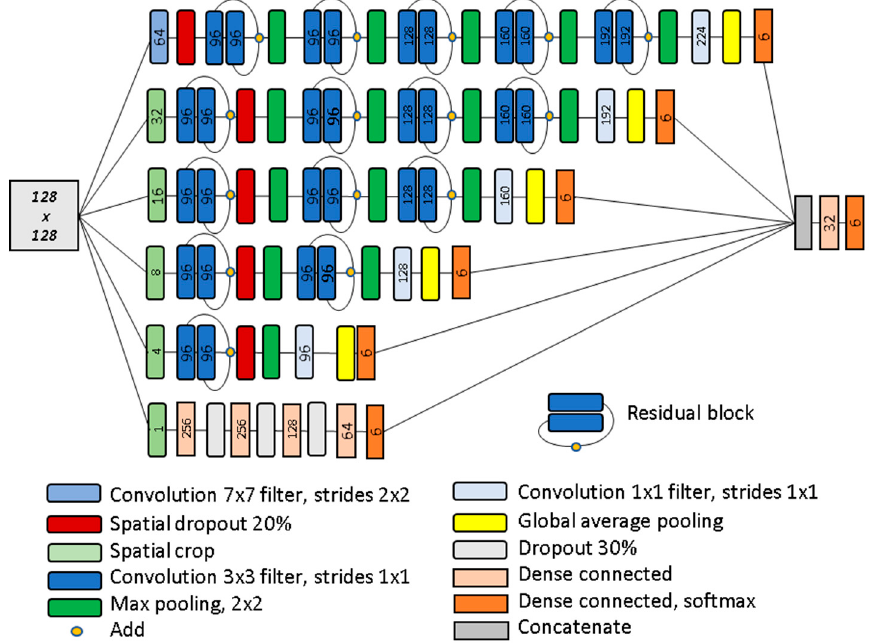
Figure 3. Schematic of the MSRE network developed in the study. Input image size was a 128 by 128 pixels shown as the large grey square. Numbers represent the number of features output from a convolution or dense layer, except for the cropping layers where the crop dimension is shown.